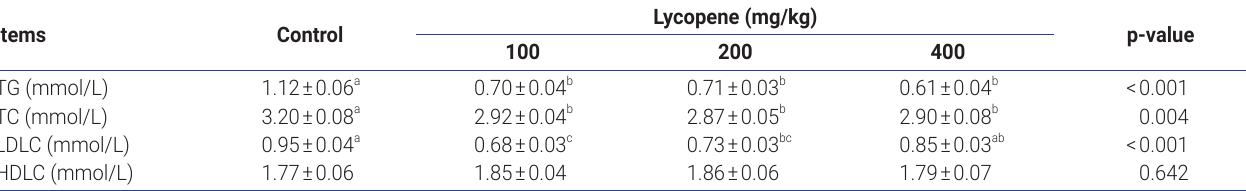
Table 5. Effects of lycopene on serum lipid level of broiler chickens